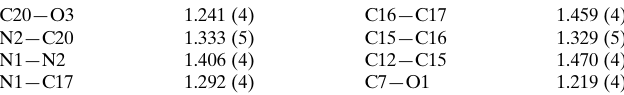
Table 1 Selected bond lengths (A˚ ).